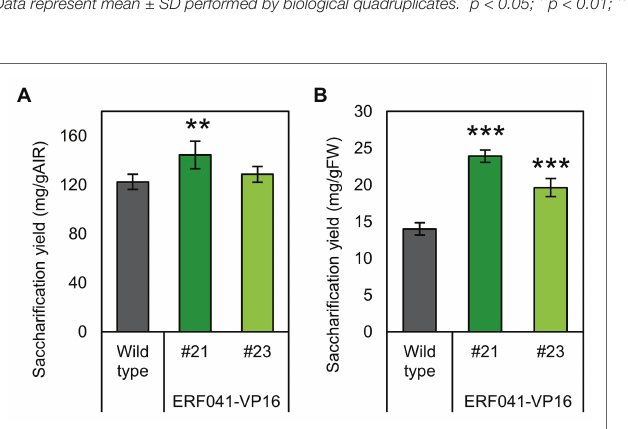
FIGURE 5 | Enzymatic glucose yield of ERF041-VP16. (A) Saccharification yields per AIR and (B) per FW. Data represent mean ± SD performed by biological quadruplicates. ** p < 0.01 and *** p < 0.001 by Dunnett’s test.